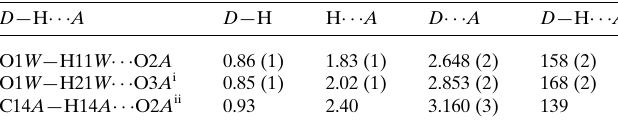
Table 1 Hydrogen-bond geometry (A˚ , (cid:4) ).